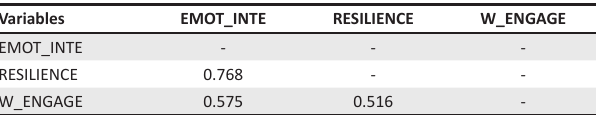
TABLE 4 : Heterotrait–monotrait